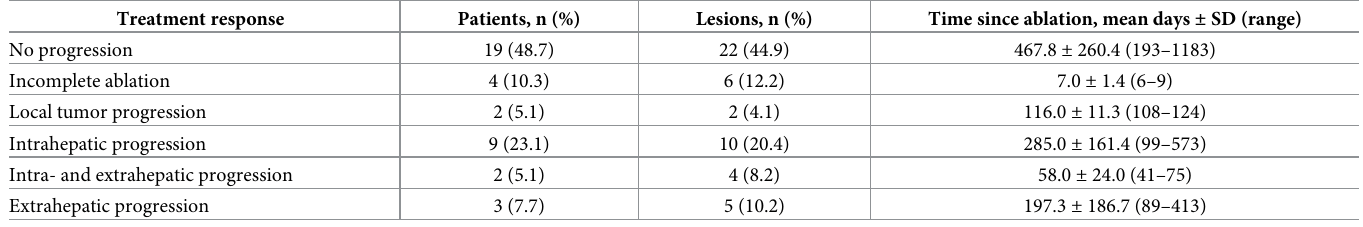
Table 3. Treatment response to microwave